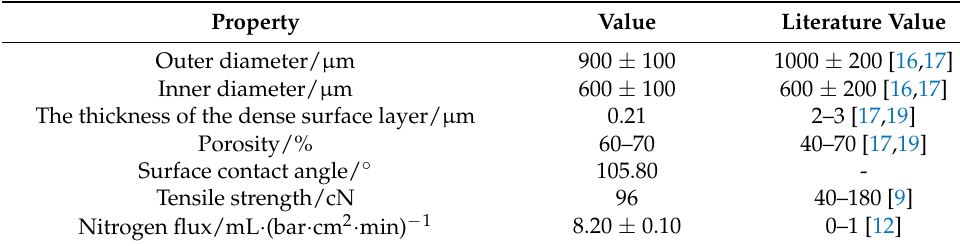
Figure 7. The morphology of the PMP HF membrane: ( a ) the overall cross-section structure, ( b ) the cross-section near the outer surface, ( c ) the partial cross-section structure; ( d ) the outer surface of the membrane; ( e ) the surface roughness of the membrane. Table 5. The configuration information and gas permeability performance of the PMP membranes and the corresponding values of the comparison obtained from the literature of Table